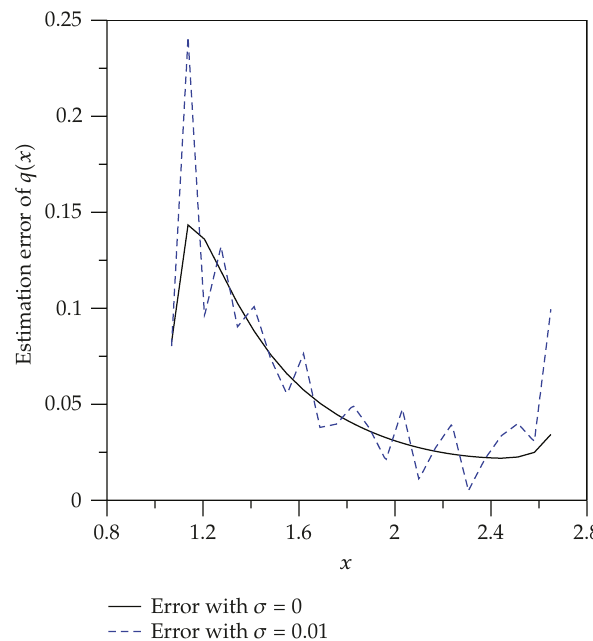
Figure 2: Example 6.2 of identifying q (cid:6) x (cid:7) , the estimation errors were